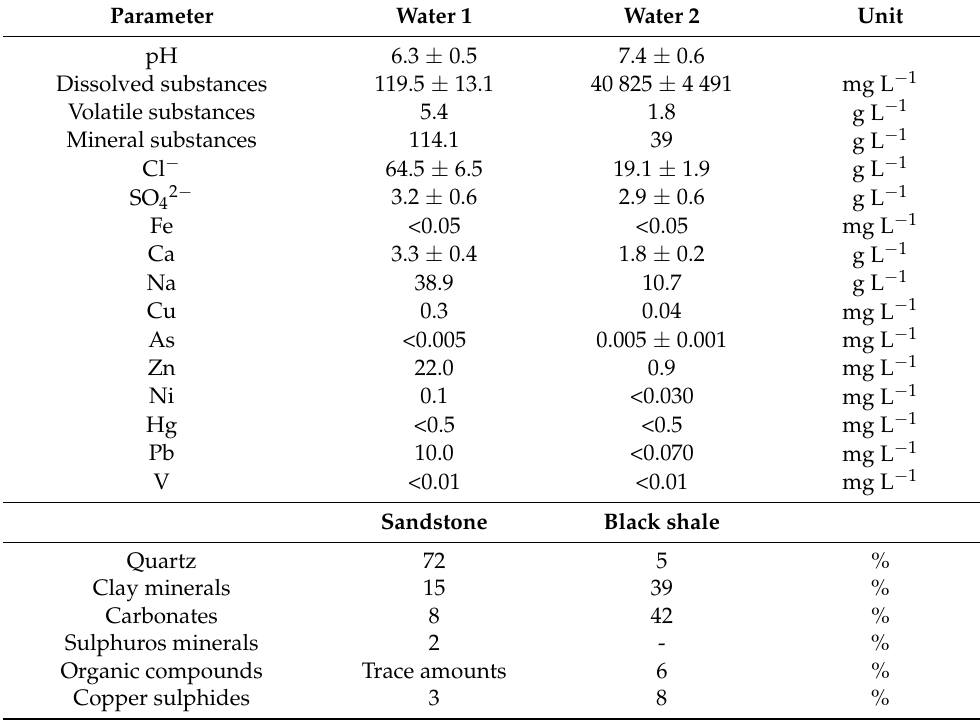
Table 1. Physicochemical parameters of the mine waters and the petrographic composition of the rock types from